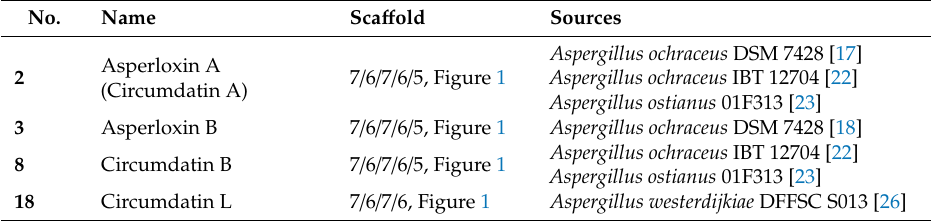
Table 3. Structures and Biological sources of Type C Oxepine-Pyrimidinone-Ketopiperazine NRPs.